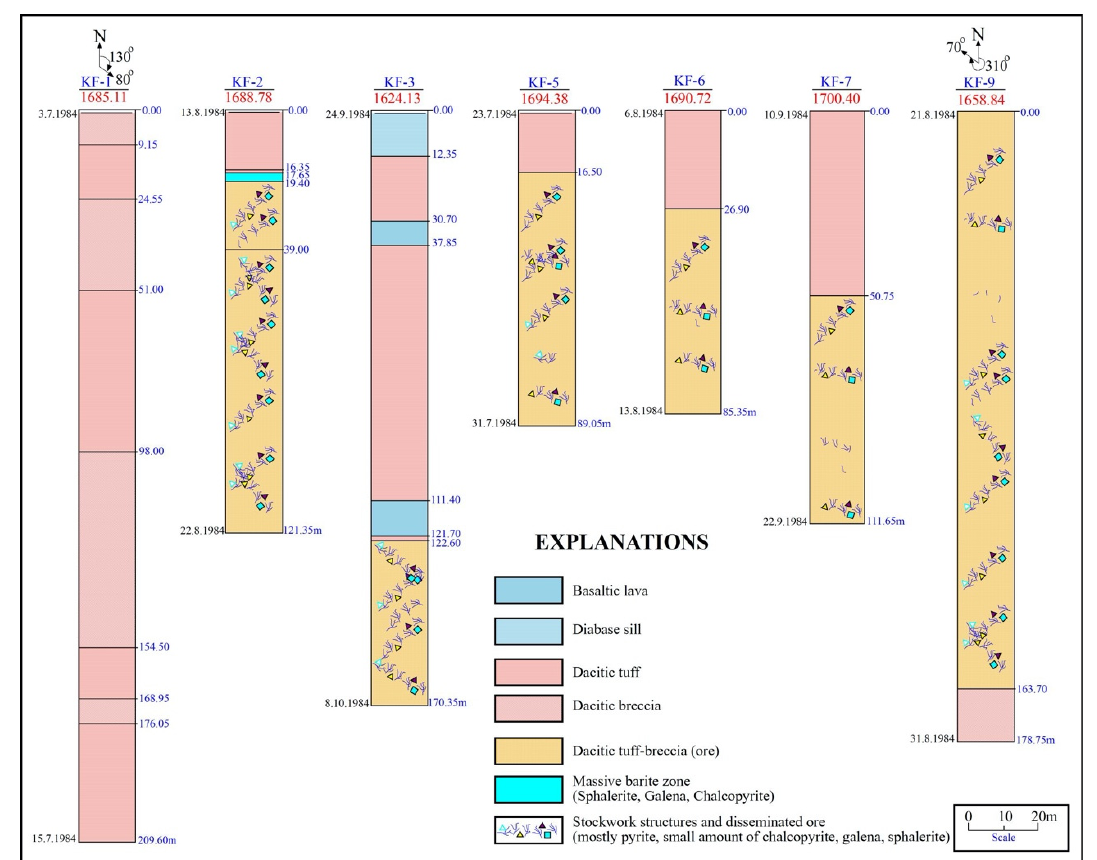
Figure 5. Drill core log of the Cerattepe-Artvin area, modified after [31].